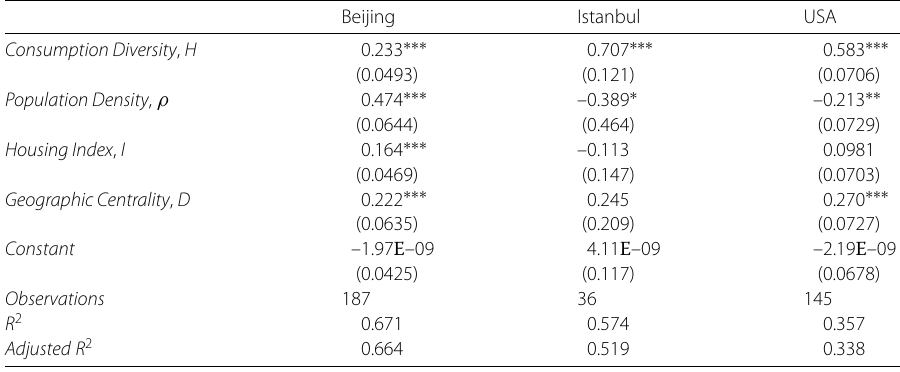
Table 4 Regression coefficients for prediction of Economic Growth using Consumption Diversity Beijing Istanbul USA ConsumptionDiversity ,